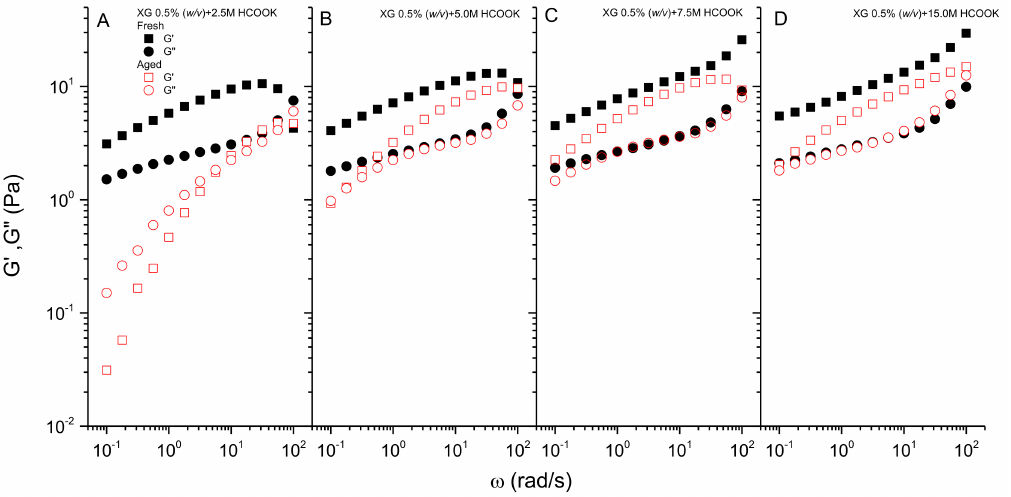
Figure 5. Effect of aging on the viscoelastic behavior for XG 0.5% ( w/v ) in potassium formate 2.50 M ( A ), 5.00 M ( B ), 7.50 M ( C ), and 15.00 M ( D